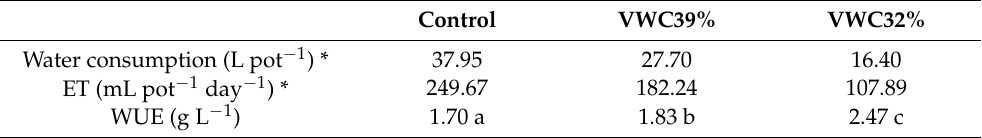
Table 2. Water consumption, average daily evapotranspiration (ET), and water-use efficiency (WUE) of Hebe plants after 152 days of cultivation at three different volumetric water contents